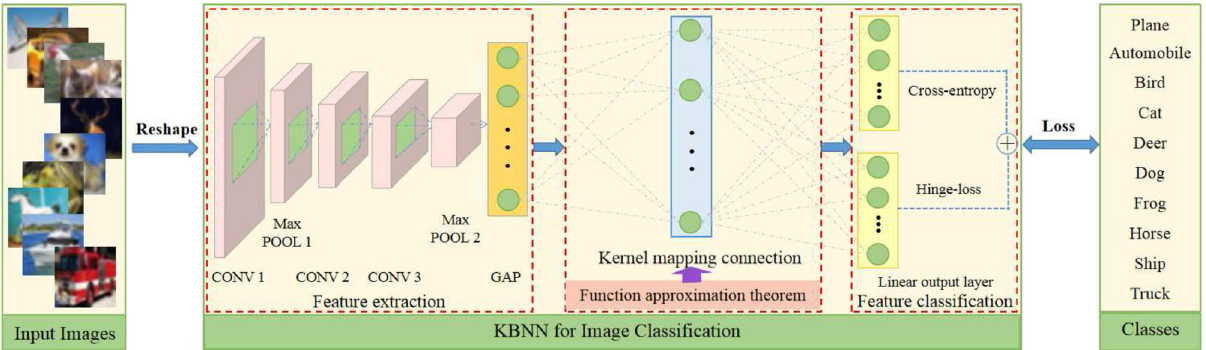
Fig. 1 Flowchart of our KBNN image classification